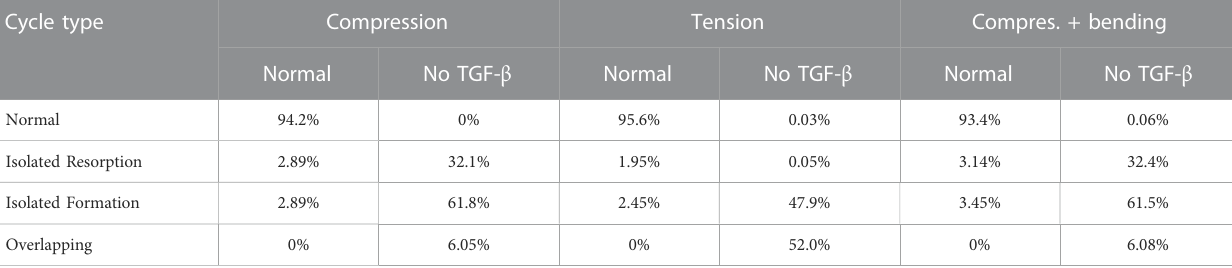
TABLE4Countofnormalcyclesandrareeventsforthethreeloadcases,inthenormalsimulationsandinthecaseswherenoTGF- β isreleasedfrombonematrixby resorption. Cycle